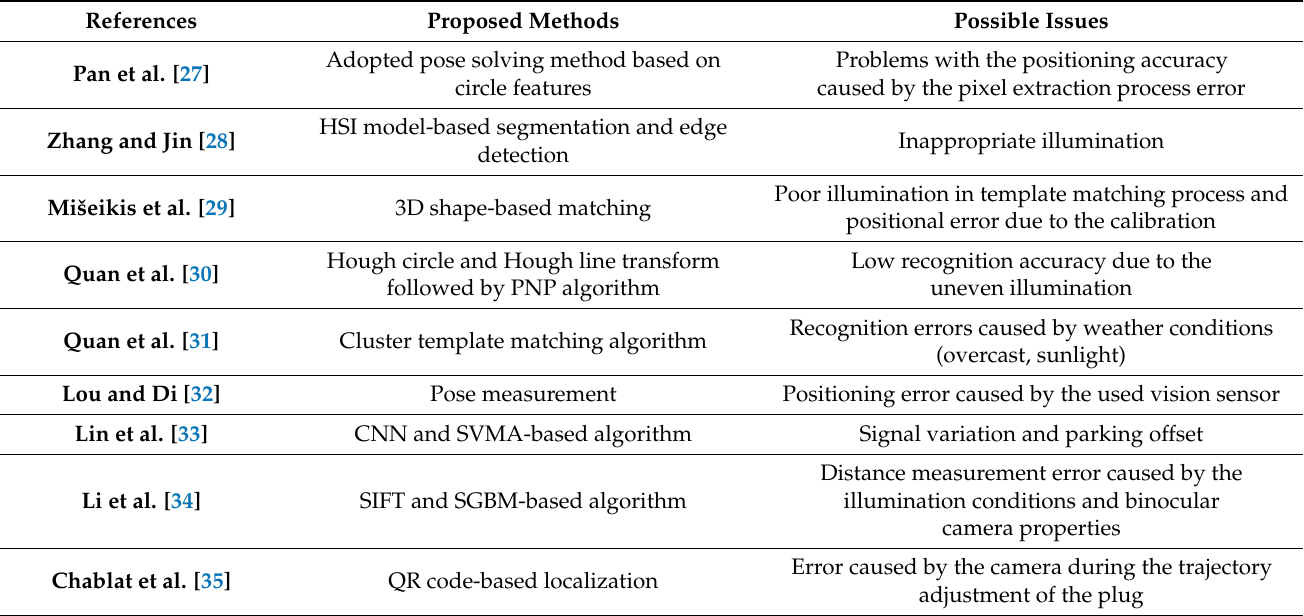
Table 1. Summary of related works, with an emphasis on proposed methods and their possible